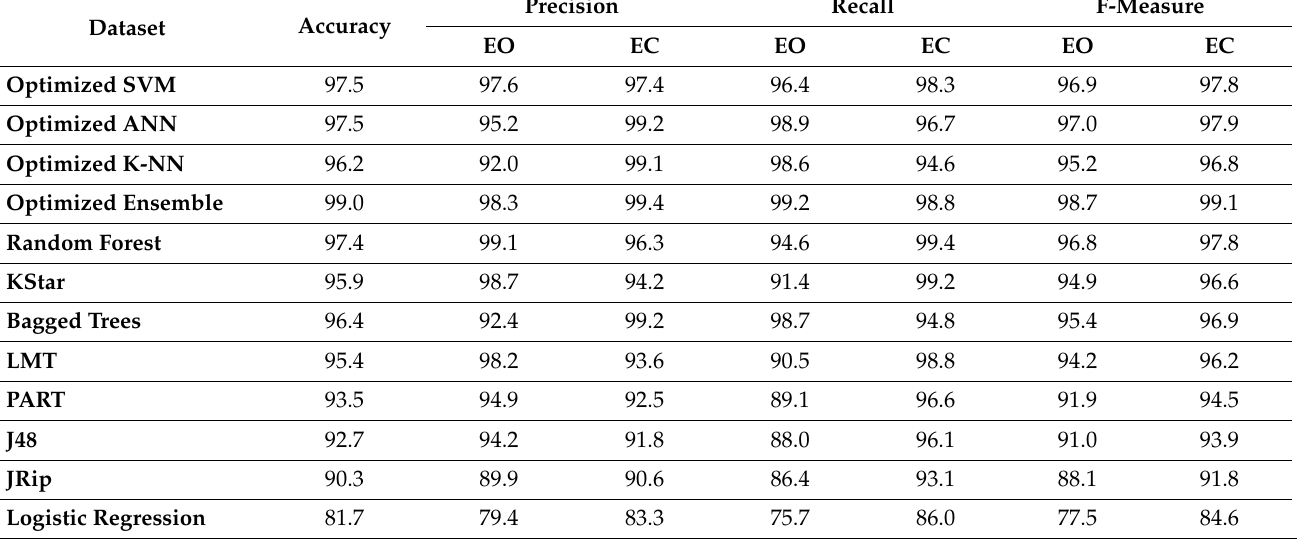
Table A4. The performance of the classifiers on Dataset SP40-M